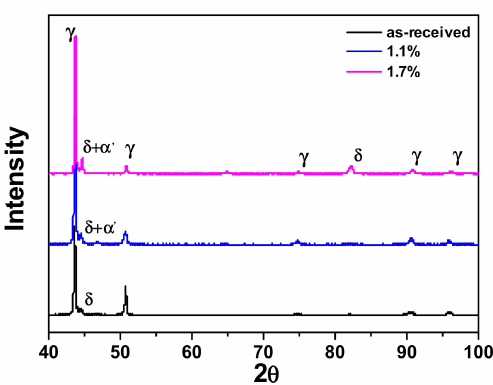
Figure 5. XRD profiles of the fatigue-failed specimens under various strain amplitudes. The intensity of the δ + α (cid:48) diffraction peak increased with the strain amplitude.